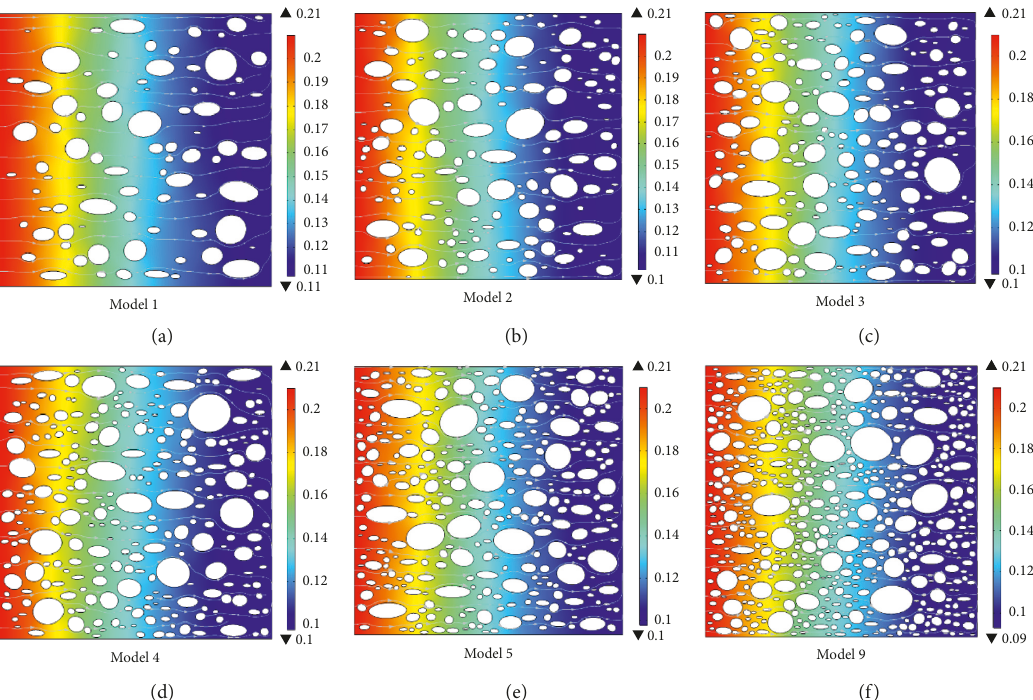
Figure 15: Chloride ions concentration distribution and streamline. (a) Model 1. (b) Model 2. (c) Model 3. (d) Model 4. (e) Model 5. (f) Model 9.